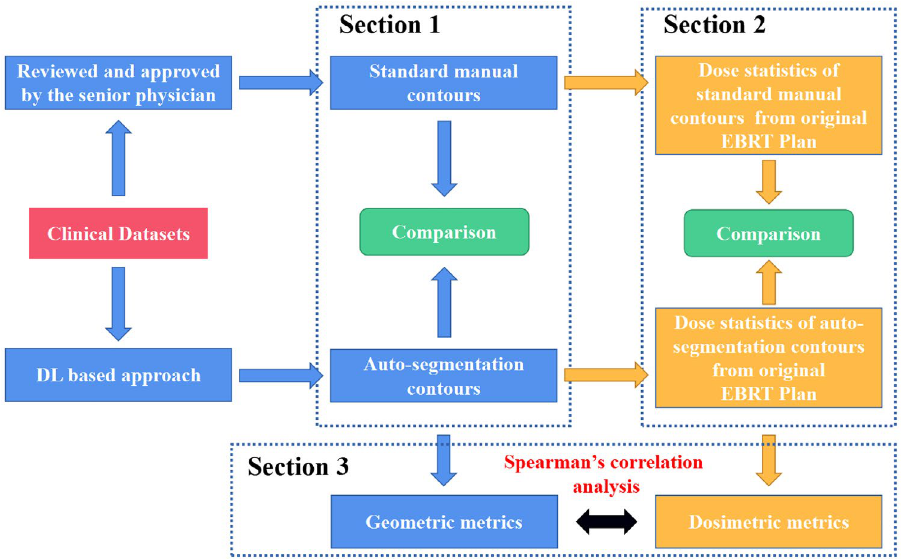
Figure 1. The flowchart of manual and DL based auto-segmentation evaluation experiment. Original EBRT plans were designed and optimized based on the standard manual contours and the auto-segmentation structures were transmitted to original EBRT plans for dosimetric